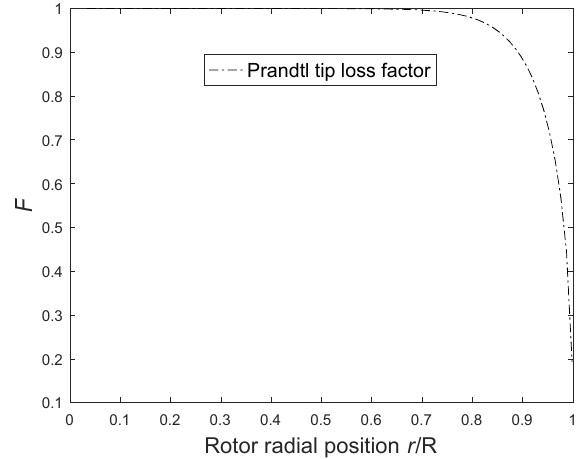
Figure 14. The distribution of Prandtl tip loss factor F .